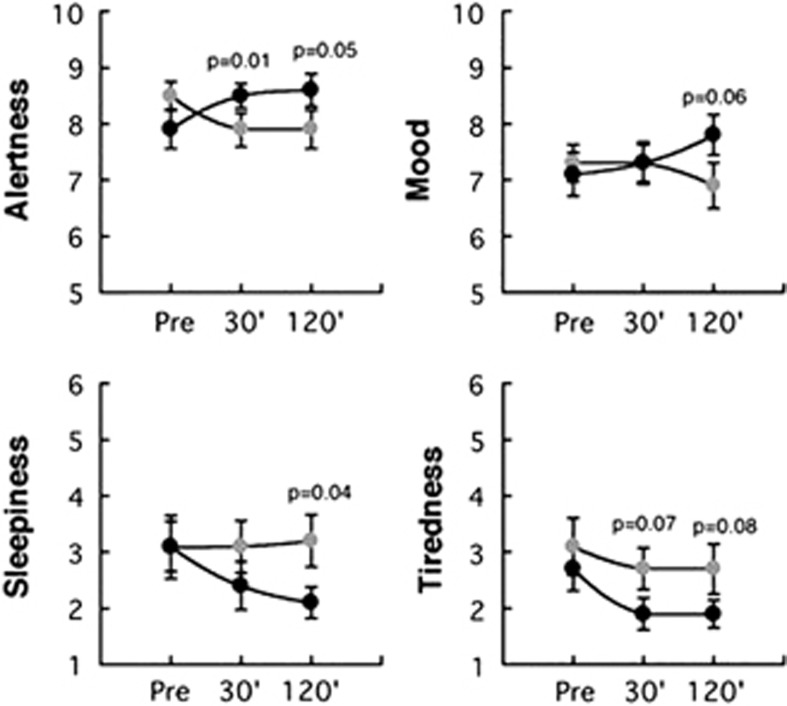
Behavioral effects of placebo and caffeine before and 30 and 120 min after their administration. Significance corresponds to comparison between placebo (gray symbols) and caffeine (black symbols) and values correspond to means and standard errors.